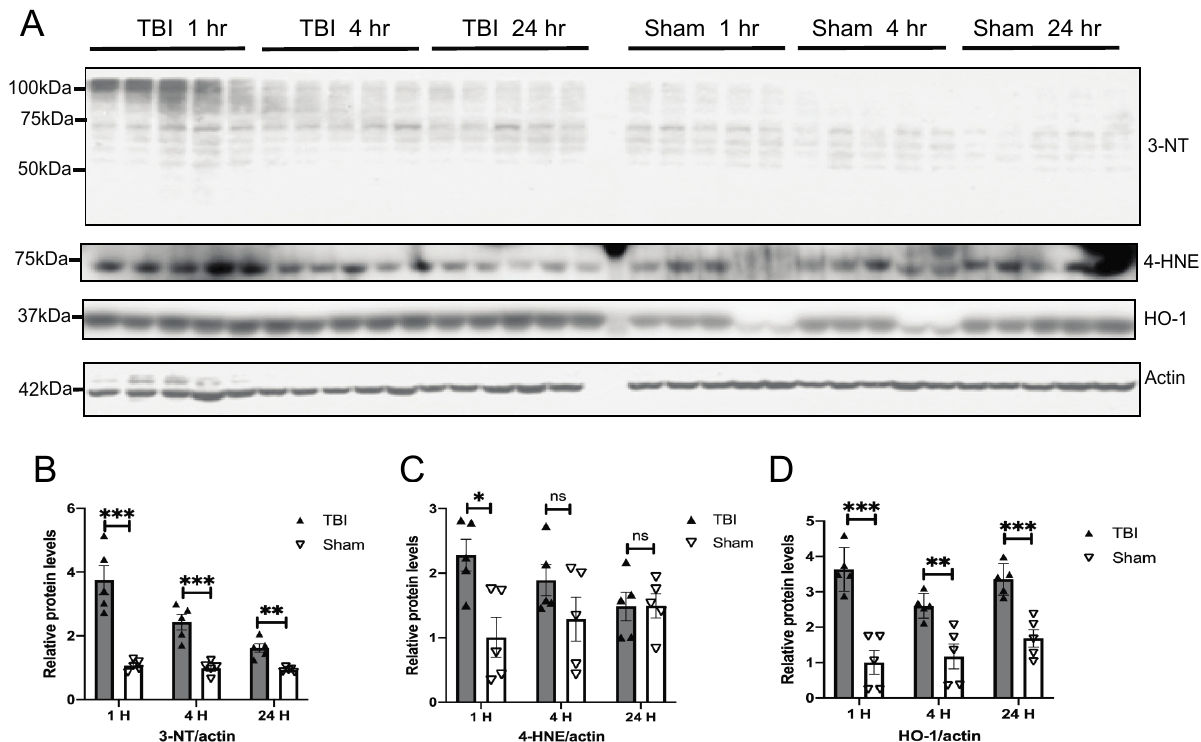
Figure 2. BOP caused increased oxidative stress in the mouse brain. ( A ) Representative Western blots demonstrated the early induction of oxidative stress markers in the mouse brain after blast ( n = 5/group). Actin was probed as an internal loading control. ( B – D ) Quantification analysis of protein oxidative marker 3-nitrotyrosine (3-NT) ( B ), lipid peroxidation marker 4-hydroxynonenal (4-HNE) ( C ), and antioxidant hemeoxygenase-1 (HO-1) ( D ) normalized to actin levels. (Data are means ± SEM, * p < 0.05, ** p < 0.01, *** p < 0.001; ns, non-significant).